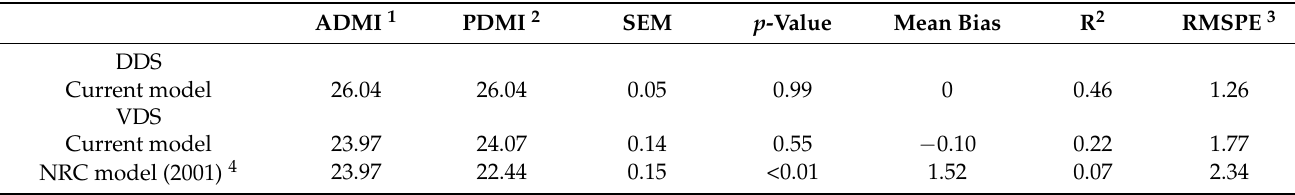
Table 4. Comparison of accuracy and precision between the current model and the NRC model in the development dataset (DDS) and validation dataset